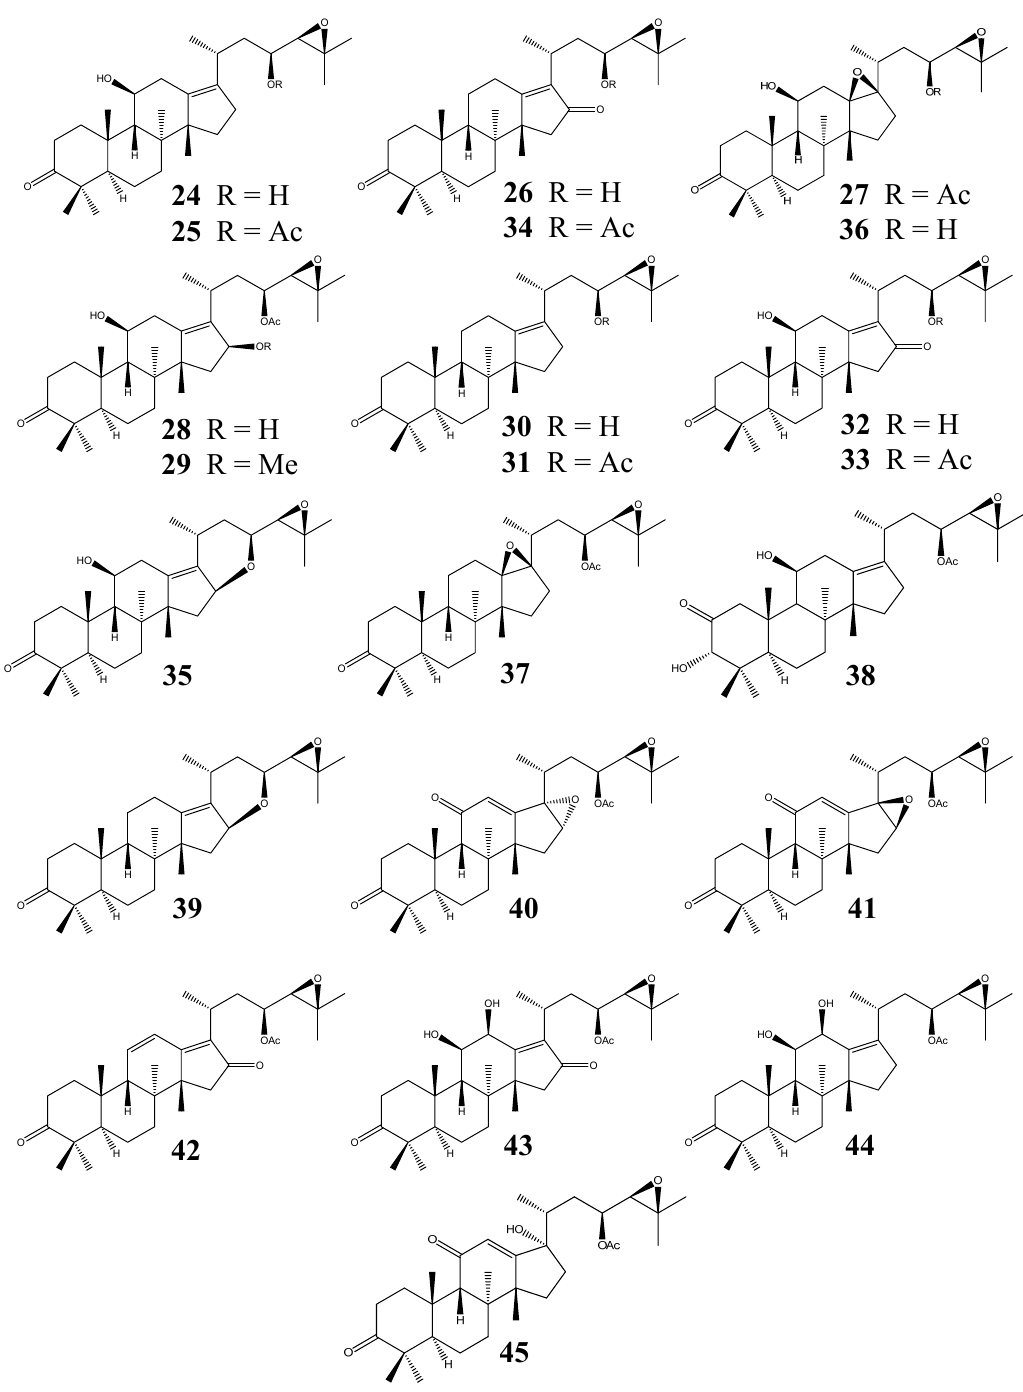
Figure 3. Structures of the alisol B series of